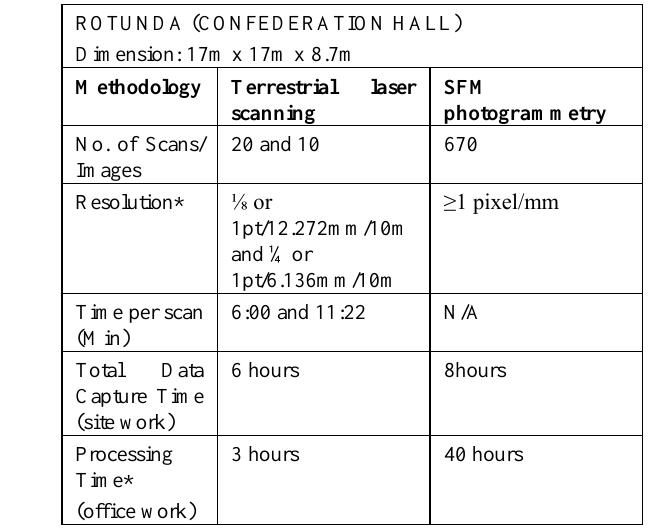
Table 1: Comparison of each methodology for the House of Commons Reading Room (left) and the Rotunda (above).